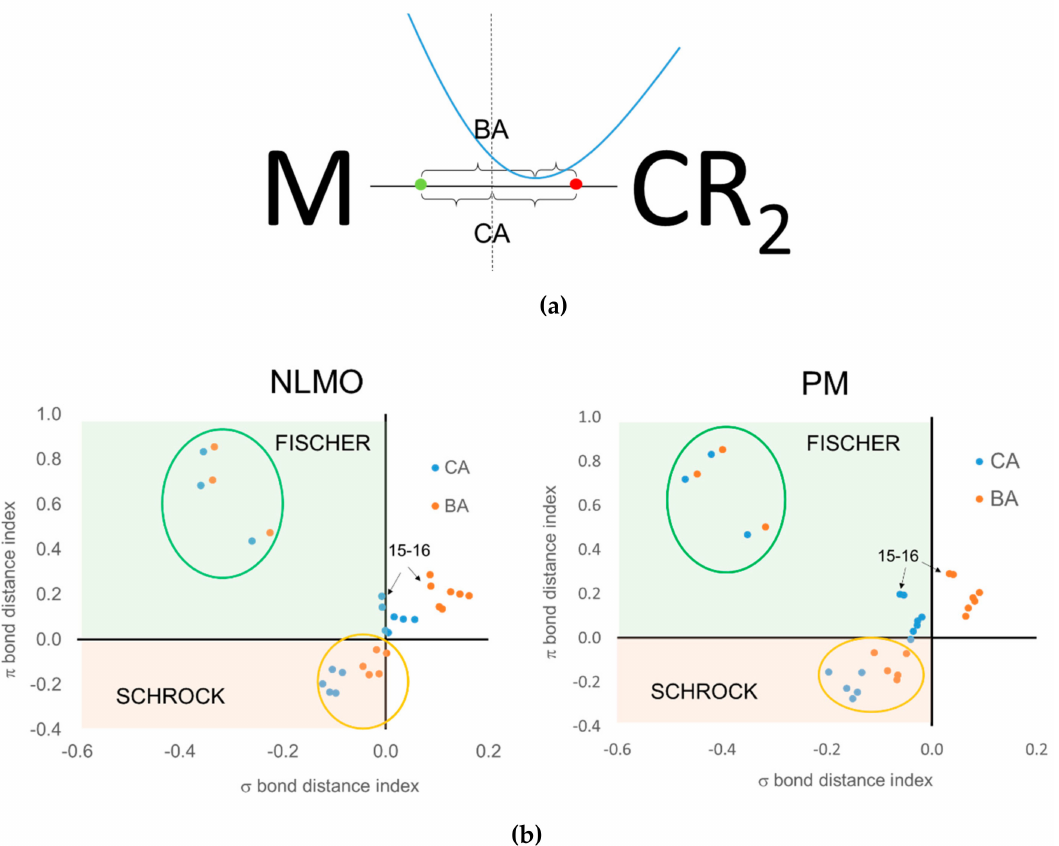
Figure 10. ( a ) Pictorial representation of a Fischer-type carbene, including the centroids of localized σ (red dot) and π (green dot) bond orbitals and relevant distances for CA (midpoint of the bond) and BA ( bcp ) criteria. ( b ) Classification of the TM carbenes according to the distance from the σ and π centroids to bond midpoint (CA) or bcp (BA). Data points corresponding to 1–4 (green circle) and 5–9 (orange